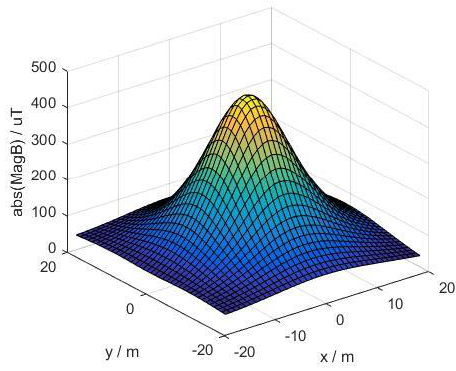
Figure 7. Magnetic field distribution simulation results.